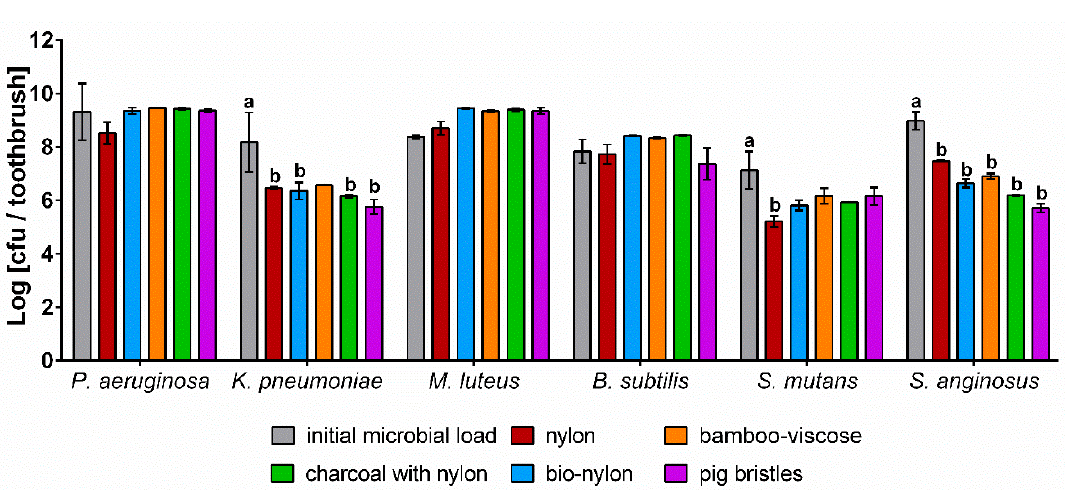
Figure 6. Logarithmic microbial counts of different bristle types after one week of artificial contamination. The following strains were used: Pseudomonas aeruginosa ( P. aeruginosa ), Klebsiella pneumoniae (K. pneumoniae ), Micrococcus luteus ( M. luteus ), Bacillus subtilis ( B. subtilis ), Streptococcus mutans ( S. mutans ), and Streptococcus anginosus ( S. anginosus ) ( n = 3). Different letters indicate significant differences at p ≤ 0.05 between groups. Where no letters are shown, no significant differences were detected.